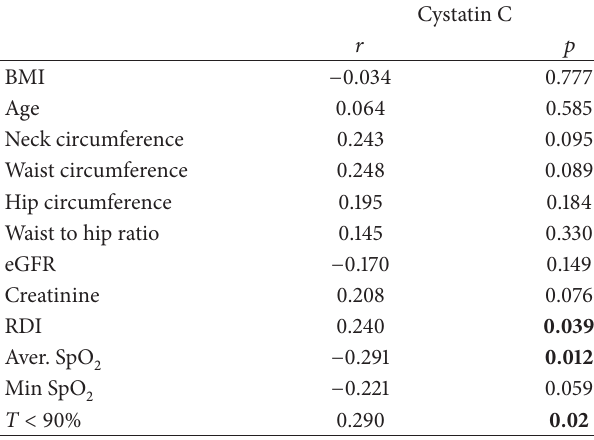
Table 4: Correlation analysis between serum cystatin C levels and anthropometric and sleep parameters in OSAS patients.